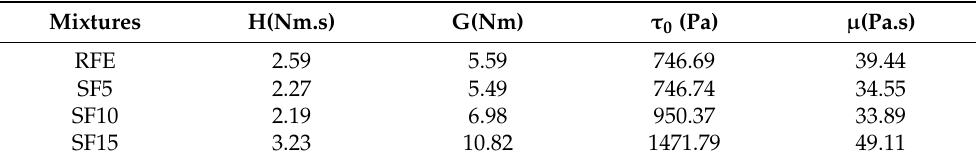
Figure 16. Bingham model results according to Jeon’s mixing ratio. Table 4. Rheology and Bingham model characteristics according to the silica fume mixing ratio (Jeon’s